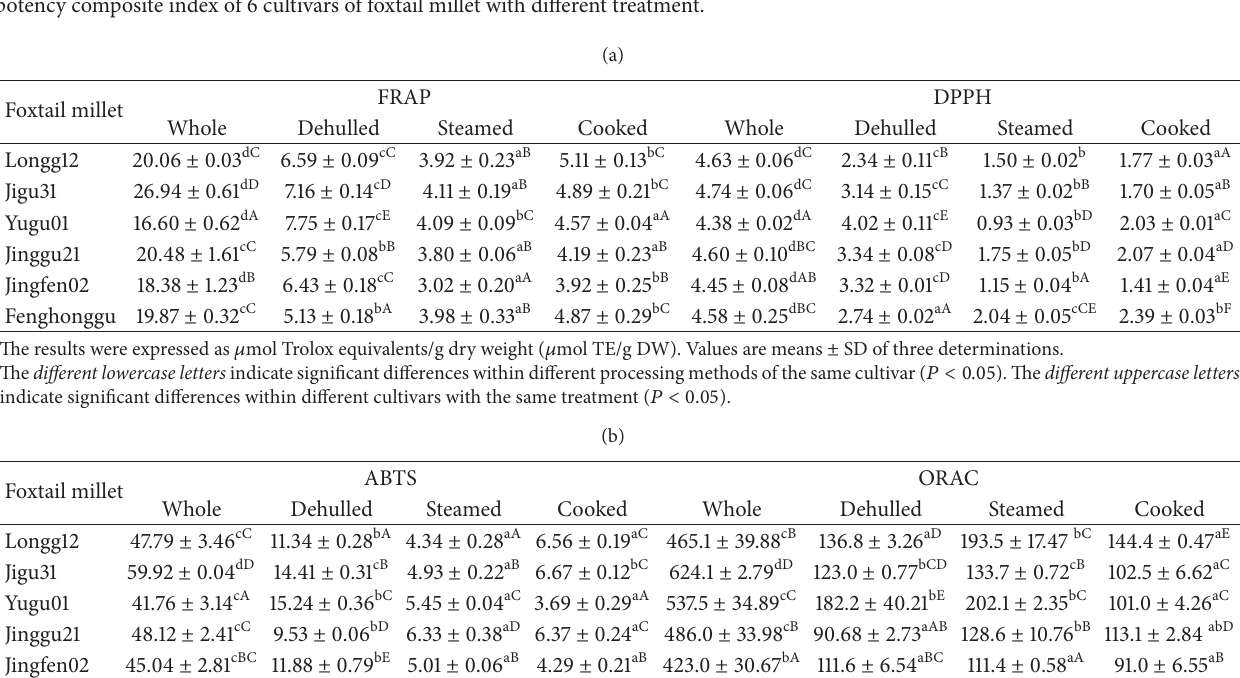
Table 2: (a) The antioxidant activity of 6 cultivars of foxtail millet with different treatment measured by the FRAP and DPPH methods. (b) The antioxidant activity of 6 cultivars of foxtail millet with different treatment measured by the ABTS and ORAC methods. (c) Antioxidant potency composite index of 6 cultivars of foxtail millet with different treatment.